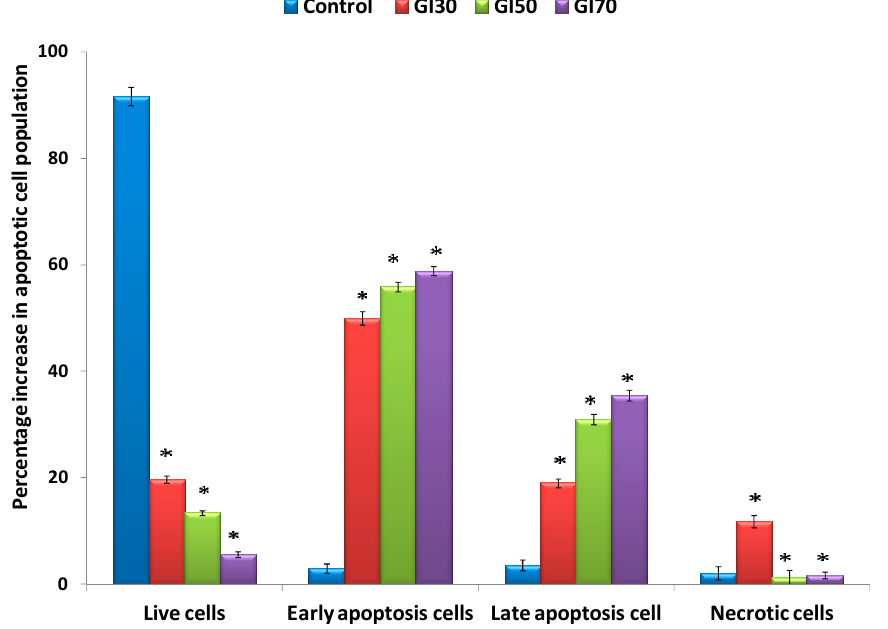
Figure 15. Effect of Epiafzelechin from C. fistula on cell apoptosis as detected by Annexin V-FITC / PI (fluorescein isothiocyanate / Propidium iodide) double staining in MG-63 cells indicates the percentage of live cells (Lower left quadrant), early apoptotic cells (Lower right quadrant), late apoptotic cells (Upper right quadrant), necrotic cells (Upper left quadrant). * indicates a statistically significant difference at ( p ≤ 0.05).